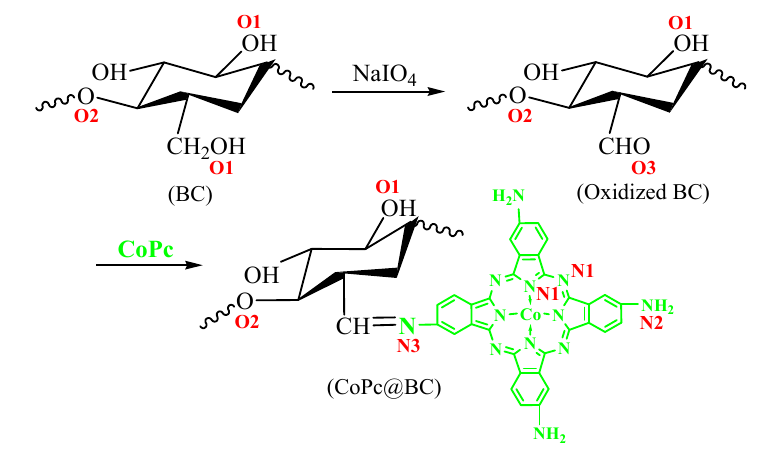
Figure 1. Synthesis route of CoPc@BC.